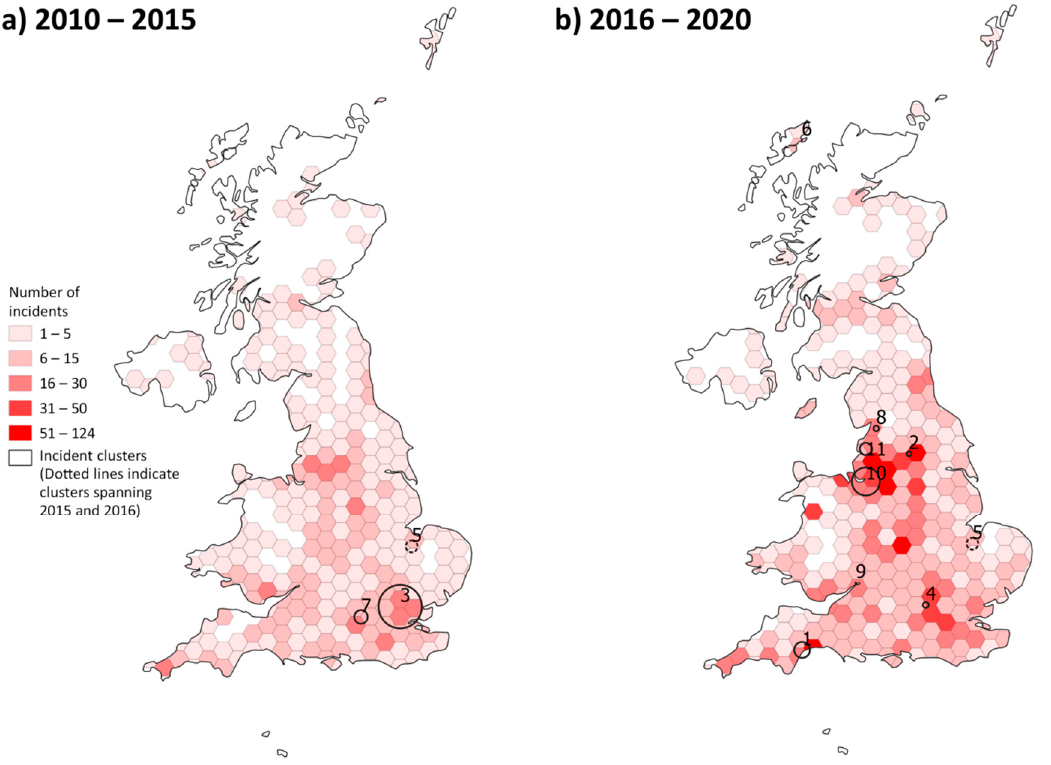
Figure 2. Choropleth map of horse-related road incidents reported to the British Horse Society across the United Kingdom divided across two time periods ( a ) 2010–2015 and ( b ) 2016–2020. Significant clusters ( n = 11) are depicted by solid / dotted circles and are labelled by their ID referenced in Supplementary information, Table S2. Cluster #5 which spans 2015 / 2016 is depicted by a dotted circle.